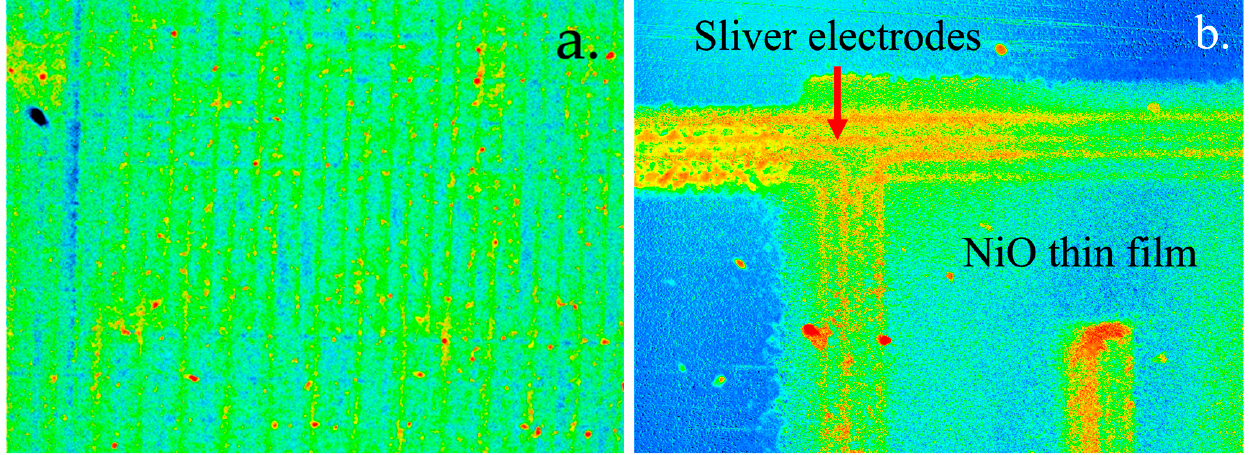
Figure 2. ( a ) ITO interdigital electrodes of partial enlargement with schematic of printing position of NiO thin film. ( b ) ITO interdigital electrodes on glass substrate.